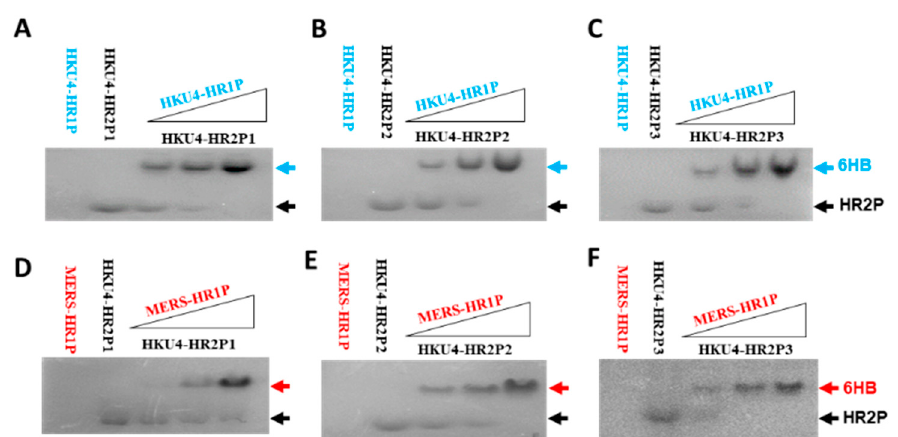
Figure 2. Determination of the interactions between HKU4-HR1P with HKU4-HR2P1 ( A ), HKU4-HR2P2 ( B ) and HKU4-HR2P3 ( C ), as well as the interaction between MERS-HR1P with HKU4-HR2P1 ( D ), HKU4-HR2P2 ( E ) and HKU4-HR2P3 ( F ) by native polyacrylamide gel electrophoresis (N-PAGE).